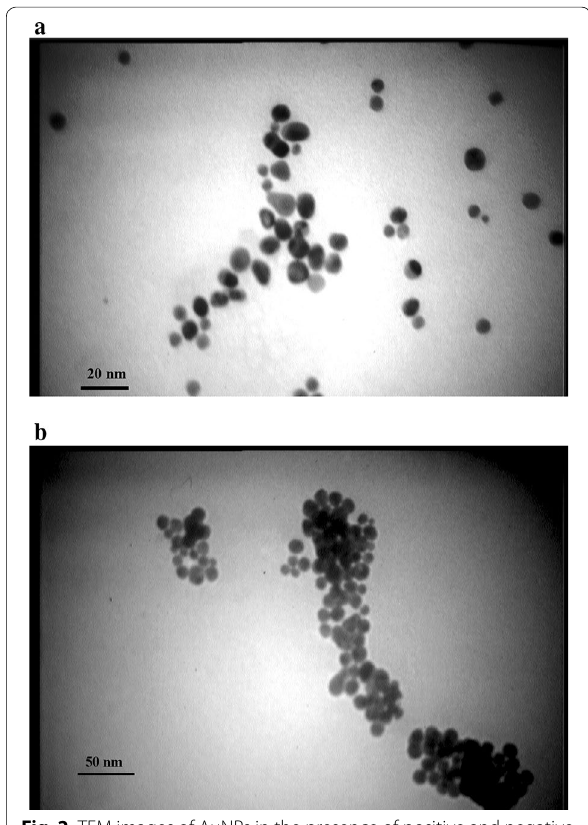
Fig. 2 TEM images of AuNPs in the presence of positive and negative samples. RNA of positive sample inhibits PNA induced aggregation of AuNPs ( a ) while AuNPs are aggregated in presence of PNA and negative sample RNA ( b